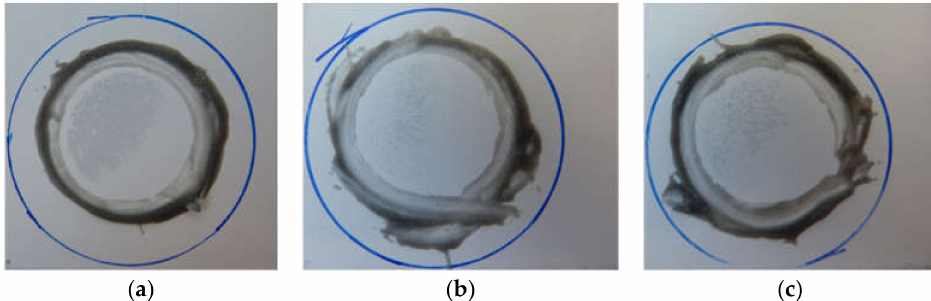
Figure 15. Appearance of the surface affected by the adhesion test area performed after the radiation with temperature and humidity test, for ( a ) the sample with sand from Ouarzazate, ( b ) the sample with sand from Dubai, and ( c ) the sample without